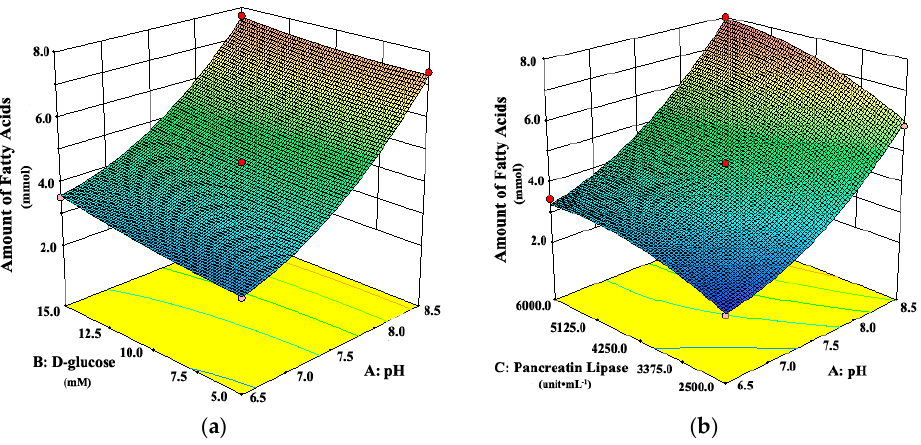
Figure 4. Response surface plots showing interaction effects of pH, D -glucose, and pancreatic lipase on the amount of fatty acids from digestion when ( a ) pancreatic lipase or ( b ) D -glucose held constant, respectively.